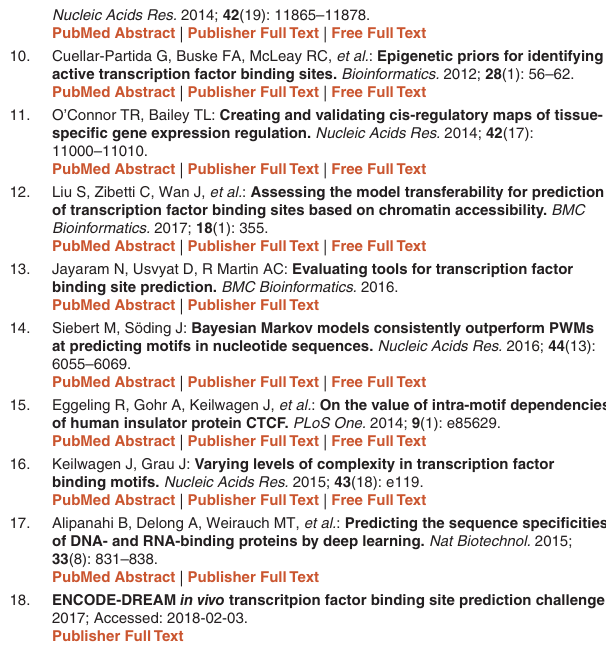
Supplementary Figure 4 (https://doi.org/10.6084/m9.figshare. 9366923.v1)